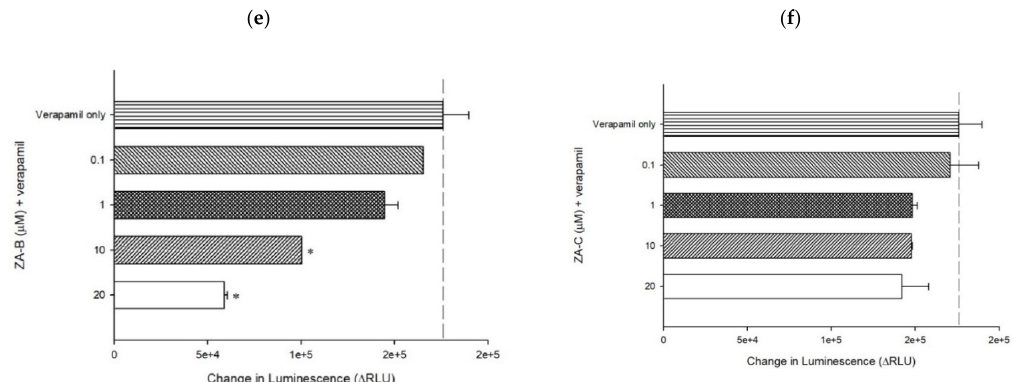
Figure 3. The P-gp ATPase modulating effects of ZA-A, ZA-B and ZA-C. ( a ) ZA-A, ( b ) ZA-B and ( c ) ZA-C inhibited basal ATPase activity in a dose-dependent trend. Verapamil-stimulated ATPase activity was reversed by ( d ) ZA-A, ( e ) ZA-B and ( f ) ZA-C. Data were analyzed in terms of the change of luminescence ( ∆ RLU). * denotes p < 0.05 compared with the ∆ RLU in basal activity group or 200 µ M verapamil treatment group. Data were presented as mean ± SE of at least three experiments, each in triplicate.